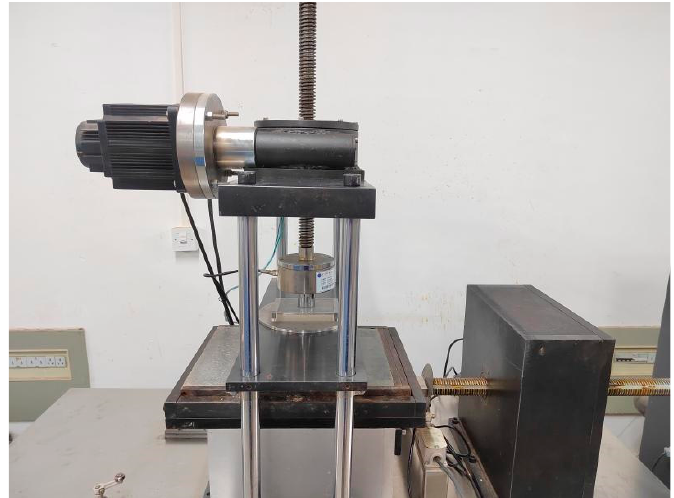
Figure 1. TSY-12D straight shear apparatus.